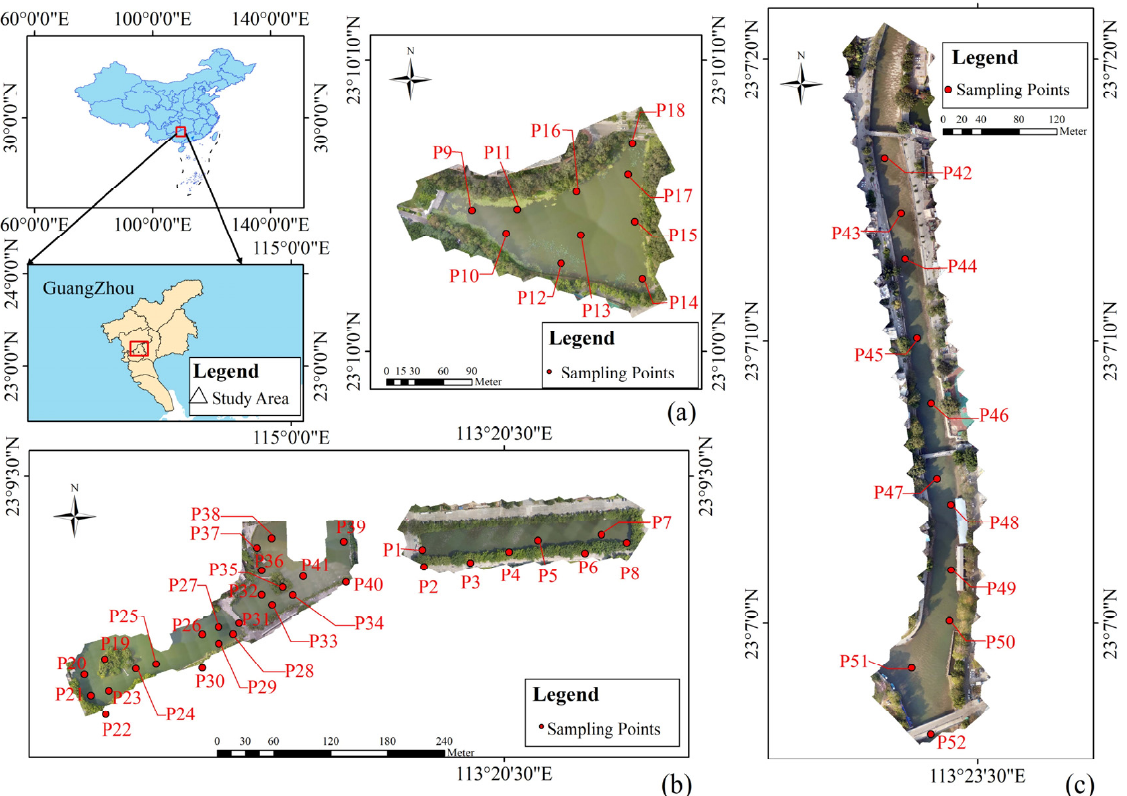
Figure 2. Sampling points in study area. ( a ) North Lake. ( b ) West Lake and Middle Lake (left); East Lake (right). ( c ) Chebei River.